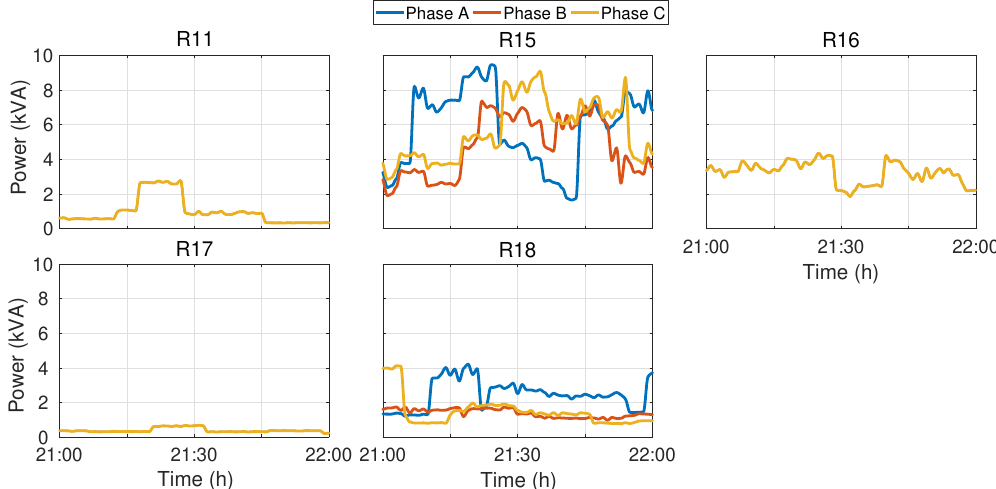
Figure 3. Nodes’ consumption per phase for the selected time